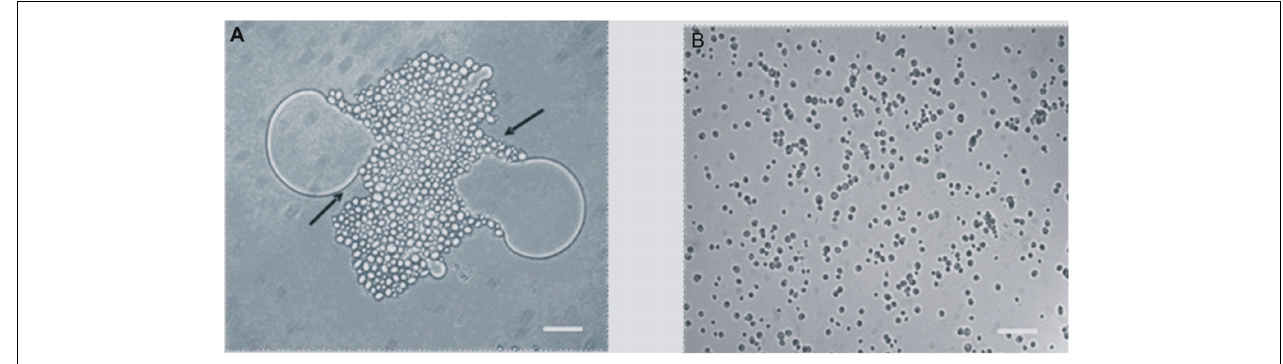
FIGURE 2 | Adhesion of Y. lipolytica NCIM 3589 to 0.5% (v/v) of (A) Bromobenzene, (B) Glucose. Bar represents 20 µ m. Arrow indicates the adhesion of the cells to the compound.